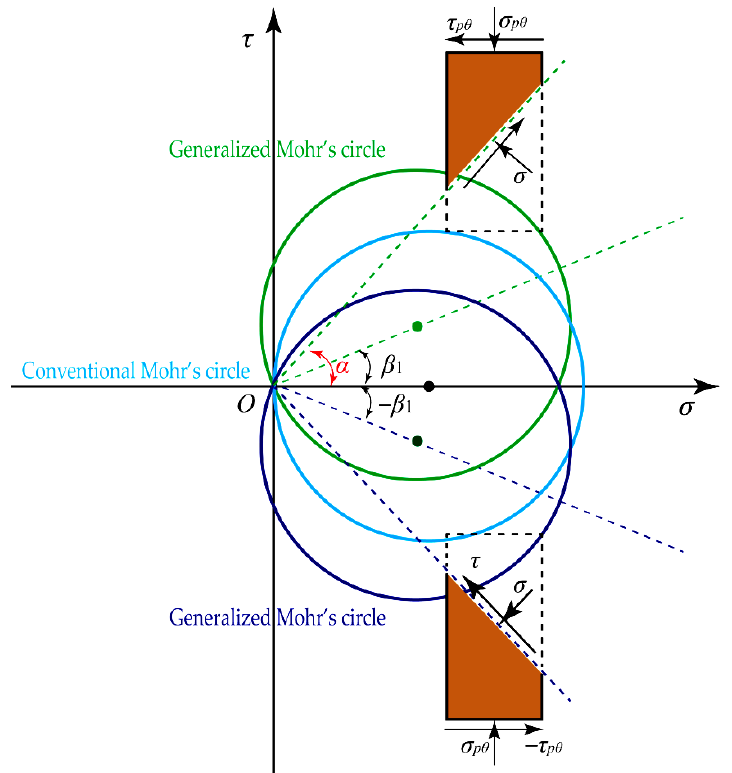
Figure 4. Generalized Mohr’s circle characterization of the stress state of an inclined pillar.